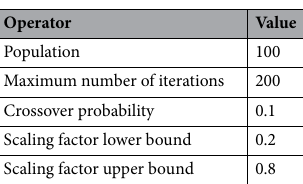
Table 3. The operators of differential evolution